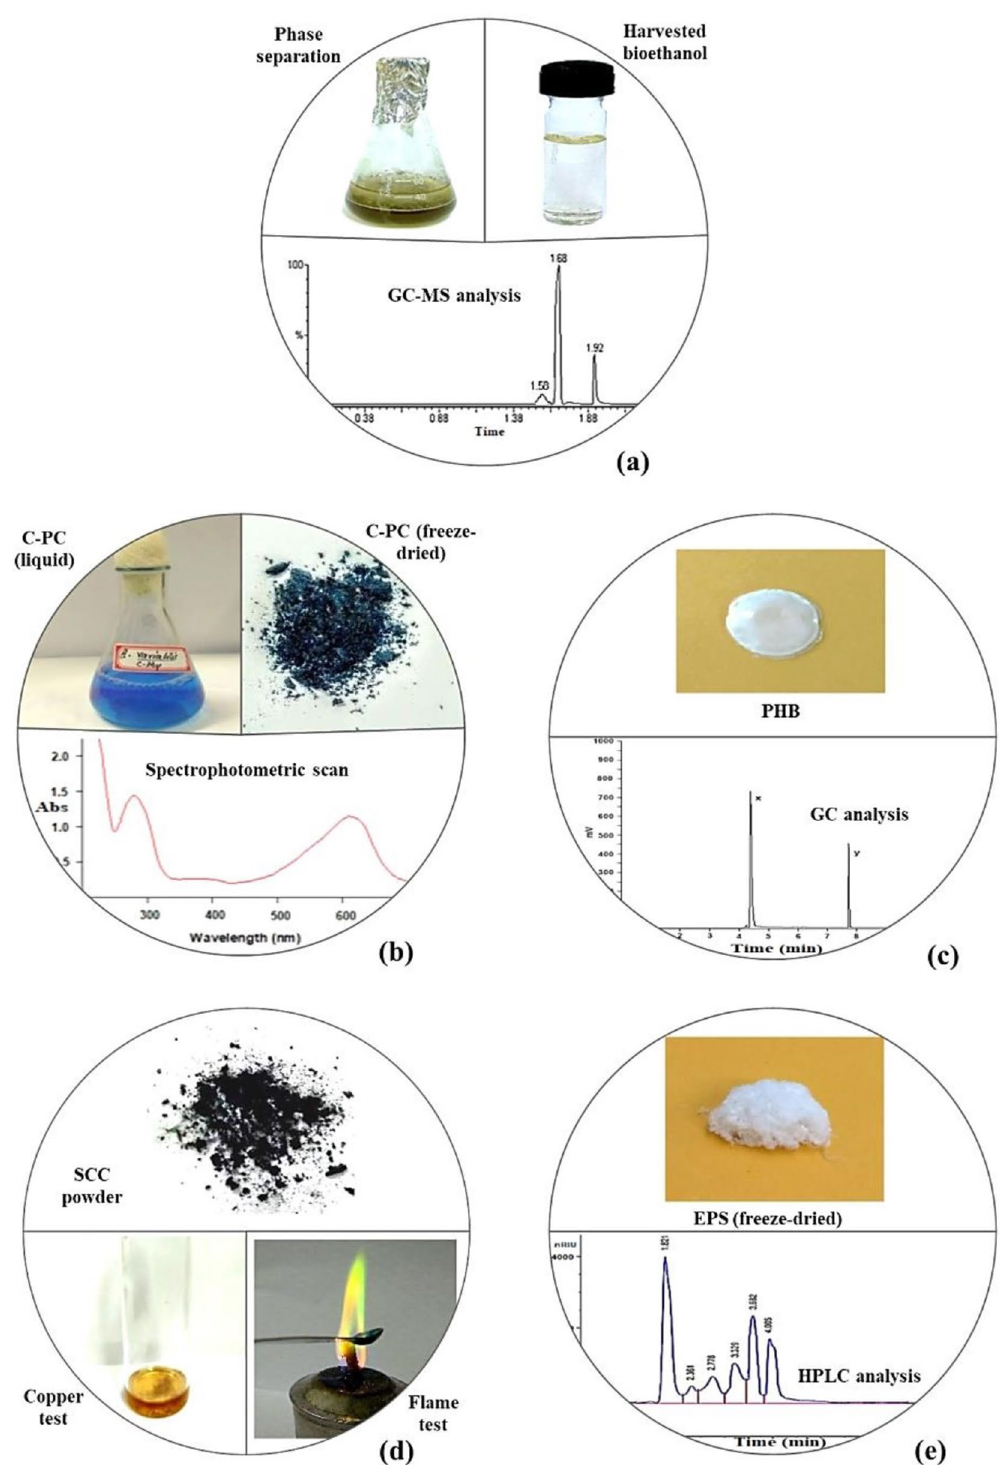
Figure 4. Production and confirmatory analyses of ( a ) Bioethanol, ( b ) C-PC, ( c ) PHB, ( d ) SCC, and ( e ) EPS from A. variabilis